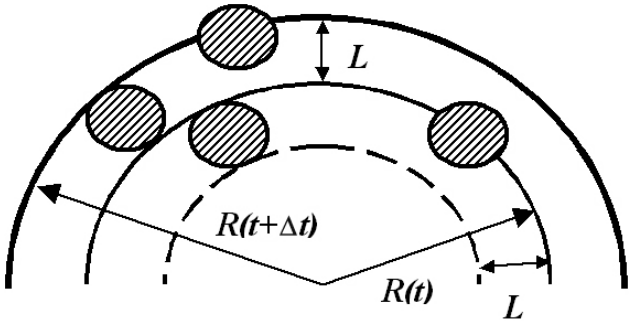
Figure 1. Diagram of the particles extraction process of the extracted substance from a droplet in a single time cycle of the ultrasonic (US) extraction discrete model.